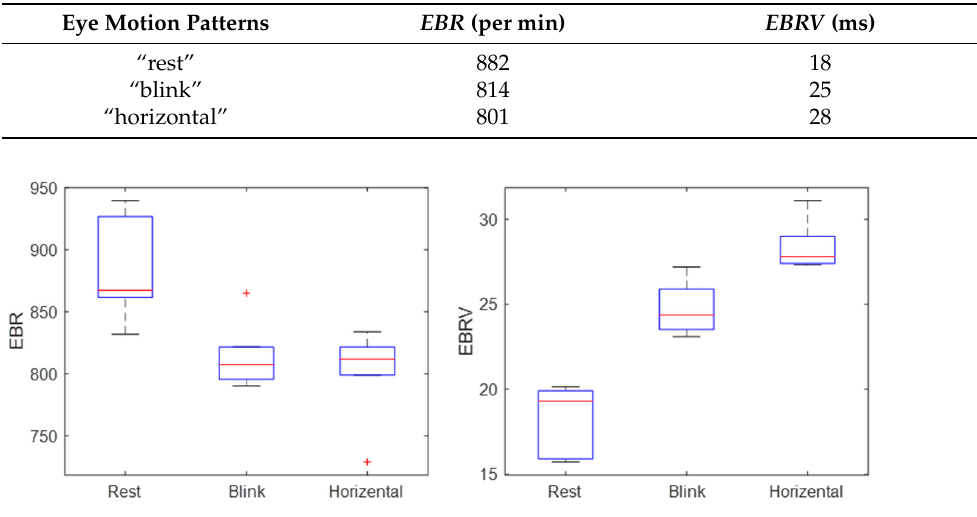
Figure 9. Eye movement classification using the wearable EOG.